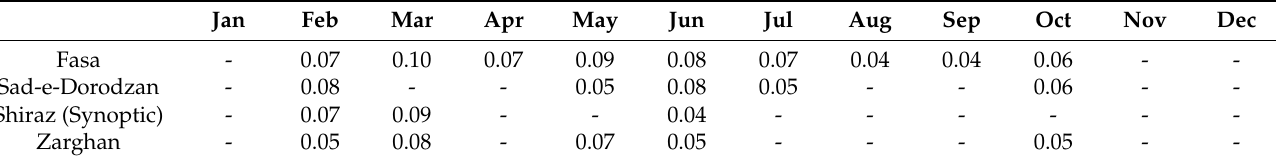
Table 8. Detected trend component in the monthly temperature time series of selected